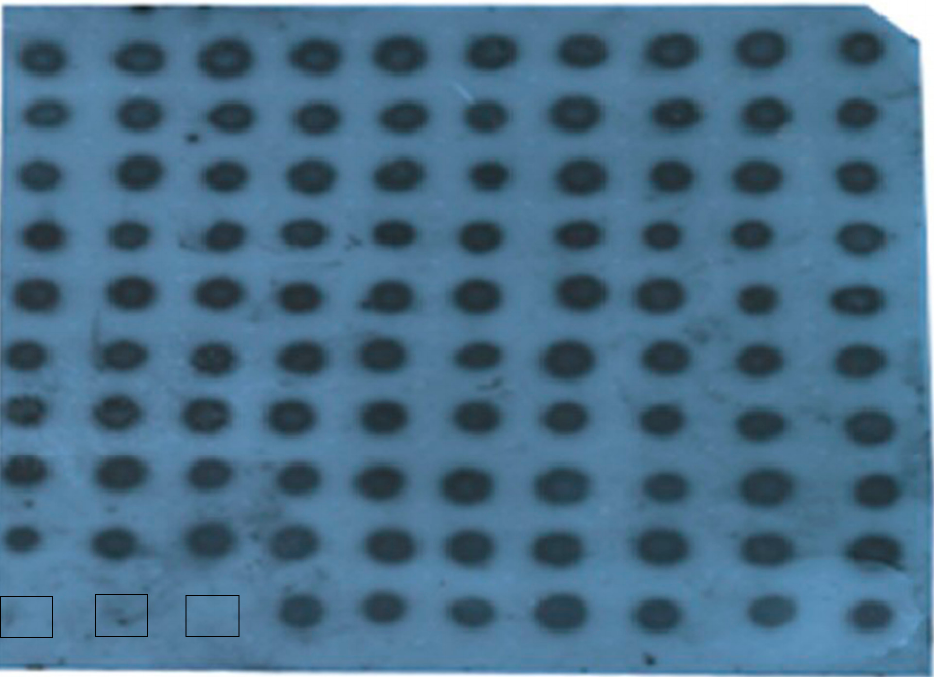
Figure 1. Detection of viral dsRNA using Northern dot blots. The first four samples in the last row, from left to right, correspond to blank control, F. graminearum PH-1, F. graminearum HN10-11F, and F. graminearum HN10 . All other samples were derived from spores of F. graminearum HN10.